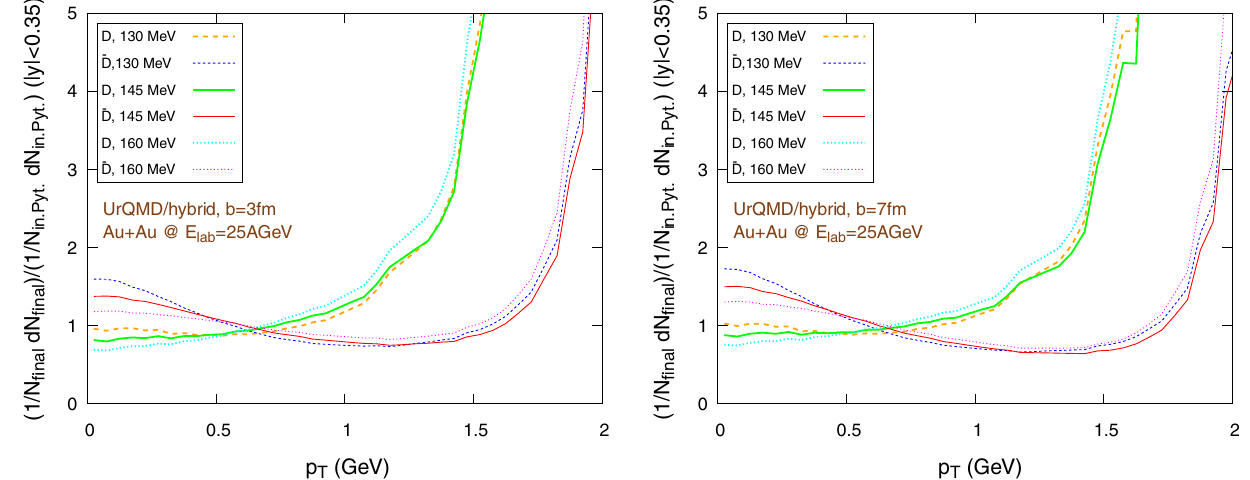
Fig. 14 ˜ R AA , i.e. the ratio of the individually normalized distributions 1 / N final d N final / d p T in Au+Au collisions and 1 / N in. Pyt. d N in. Pyt. / d p T inppcollisions(simulatedwithPythia),intherapidityrange | y | < 0 . 35,